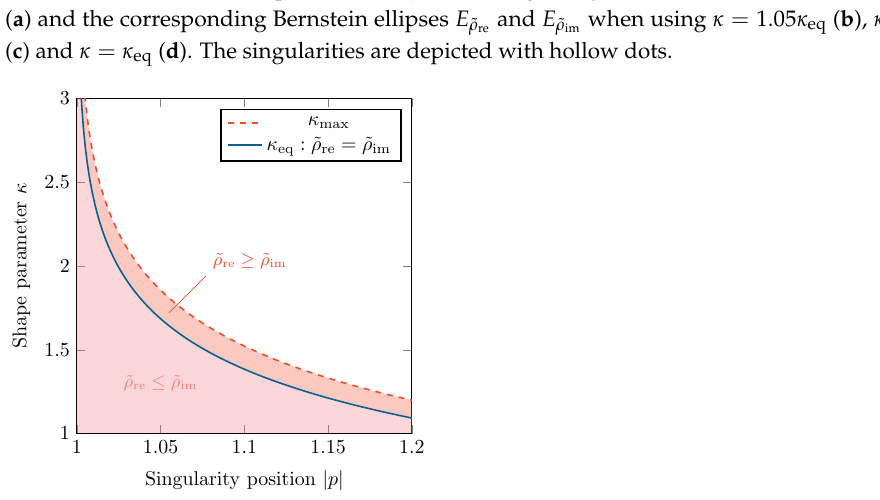
Figure 5. The different regions, denoting the relative sizes of both Bernstein ellipses, in the ( p , κ ) | |